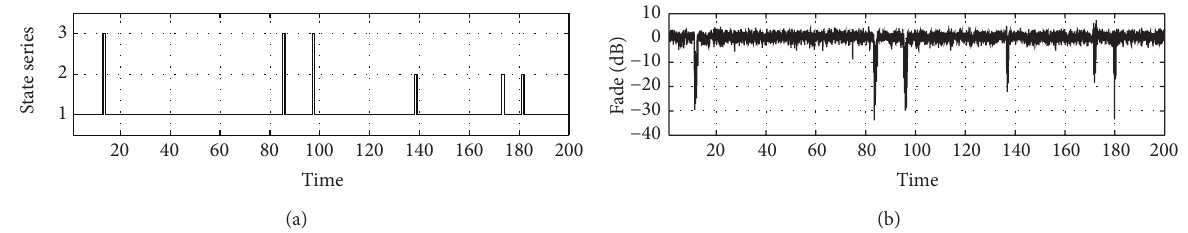
Figure 15: Signal performance of the ELMSC model: (a) state series and (b) signal fade.